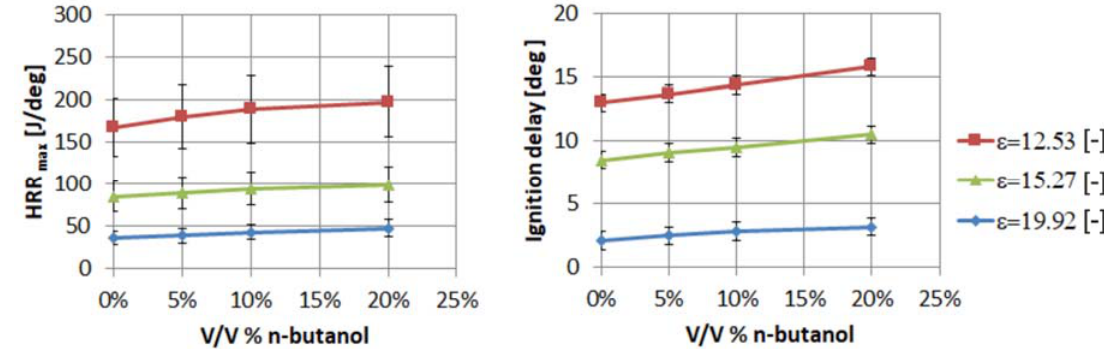
Figure 3. Change in maximum useful heat change (HRR) and Ignition delay to diesel (0 V/V% n-butanol) under different compression ratios and n-butanol ratios ( σ HRR ± 21.66%).